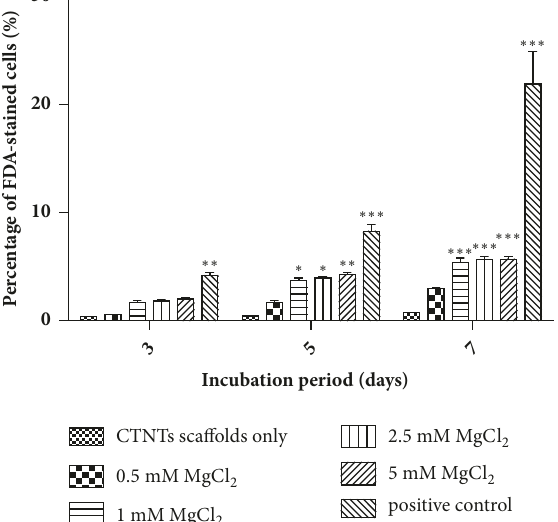
Figure 5: Percentages of FDA-stained cells cultured on polystyrene well (positive control), CTNTs scaffolds only and CTNTs scaffolds with different amounts of Mg 2+ ions adsorbed at different initial concentrations (0.5-5 mM) of MgCl 2 for 3, 5, and 7 days ( ∗ p < 0.05, ∗∗ p < 0.01, ∗ ∗ ∗ p < 0.001, n =